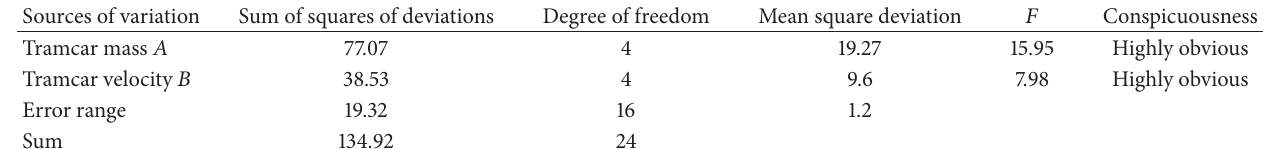
Table 4: Variance analysis of tramcar braking distance.